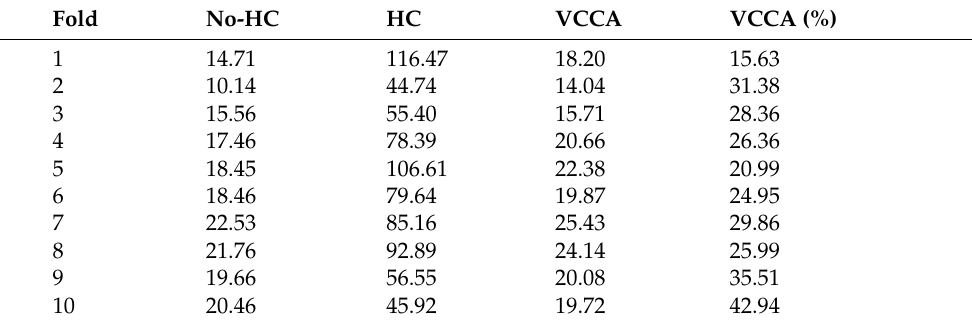
Table 12. The training times in seconds for Dataset 2.